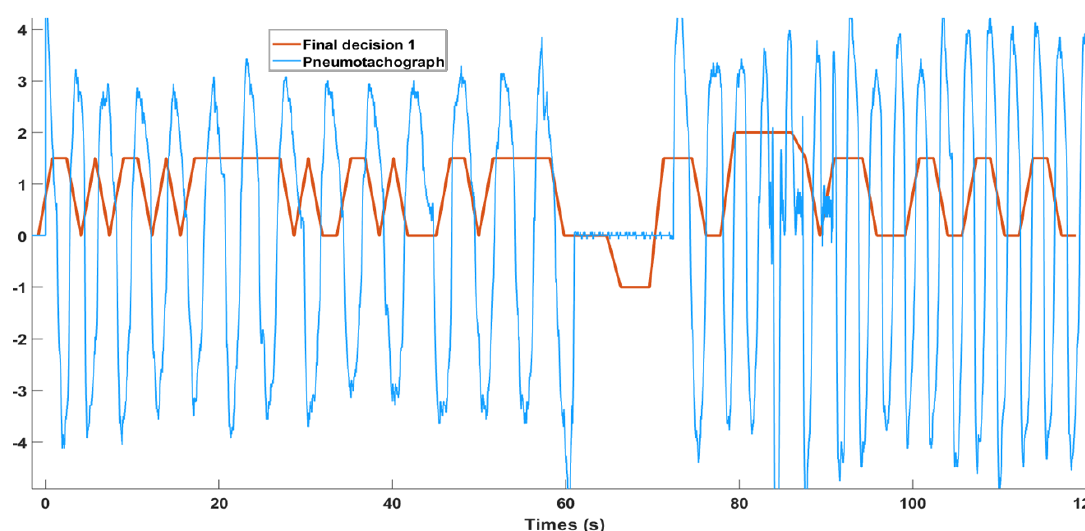
Figure 9. Final decision-making for apnea detection. Detection stat: 2—Speech; 1.5—Respiration; 0—Pauses; − 1—apnea. The reference signal: pneumotachograph is in blue, and the apnea detection signal is in